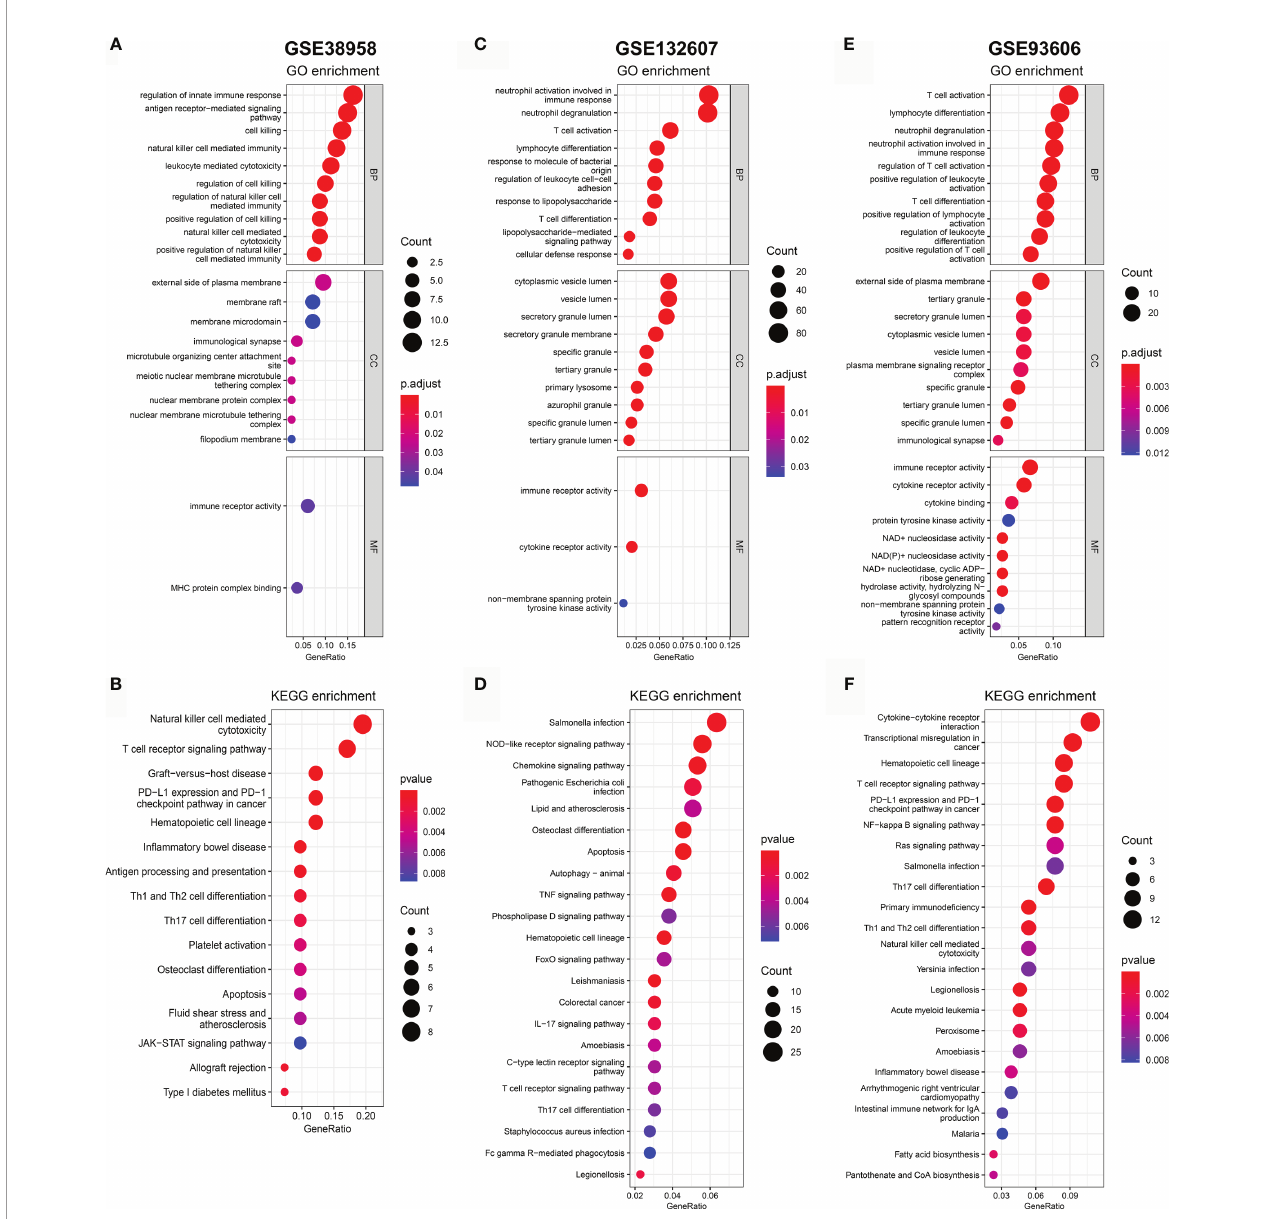
FIGURE 7 | Signi fi cant GO terms and KEGG pathway analysis for the DEGs between patients with low-expression CD247 and patients with high-expression CD247. The most signi fi cant GO enrichment and KEGG pathways in the GSE38958 dataset (A, B) , GSE132607 dataset (C, D) , and GSE93606 datasets (E, F) are